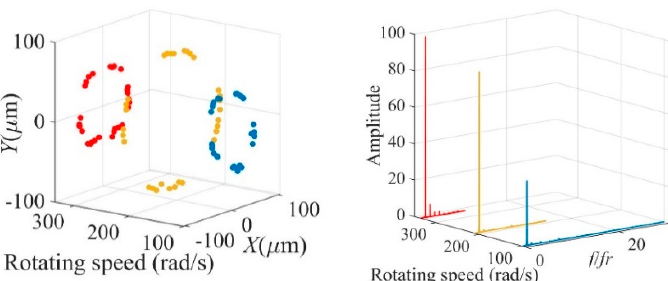
Figure 8. System response at different speeds when the oil pressure is 1.0 MPa.